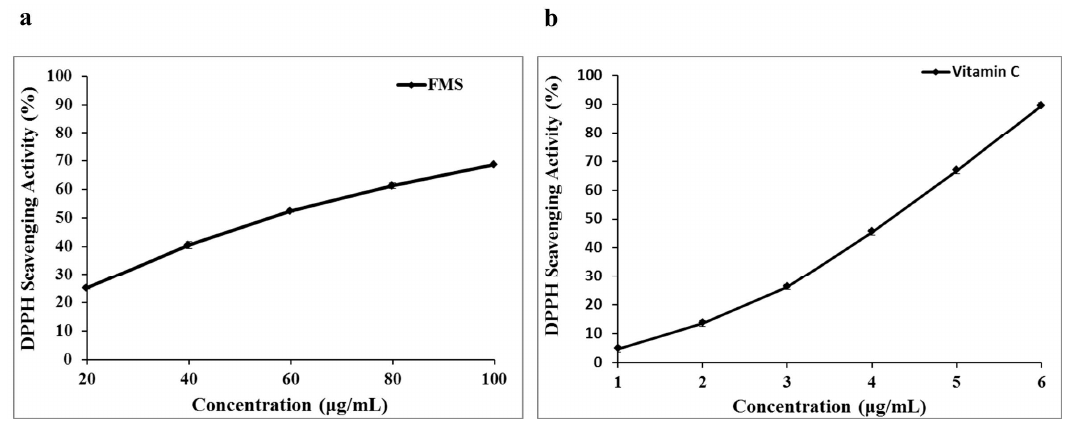
Figure 2. 1,1-Diphenyl-2-picrylhydrazyl (DPPH) radical scavenging ability of Maydis stigma (FMS) ( a ) and vitamin C ( b ).